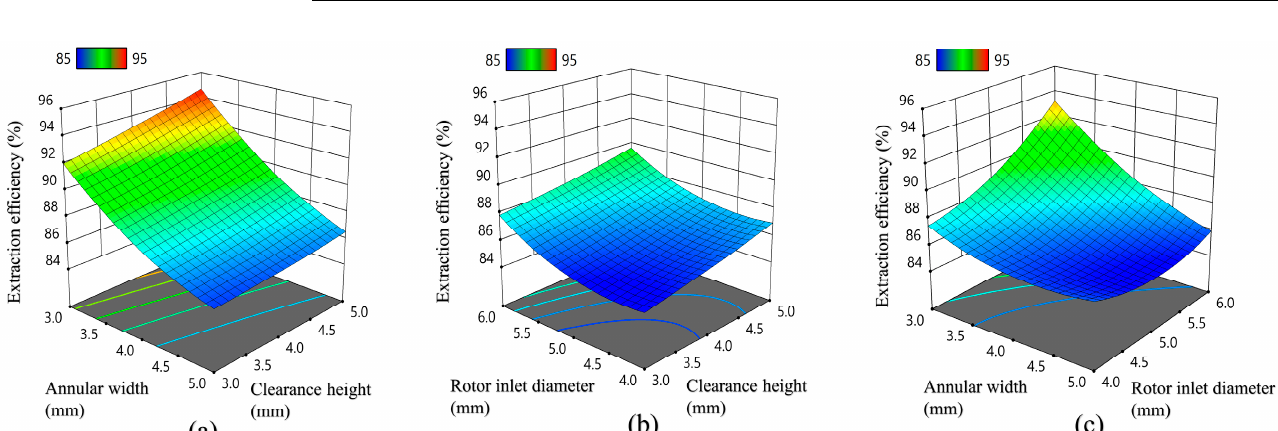
Figure 3. Response surface plots of various parameters on extraction efficiency; ( a ) take rotor inlet diameter 6.0 mm; ( b ) take annular width 3.0 mm; ( c ) take clearance height 5.0 mm.